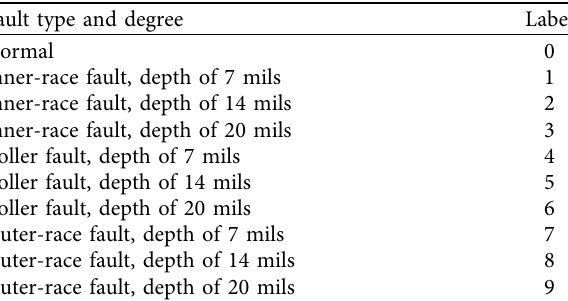
Table 11: Fault classification label table.